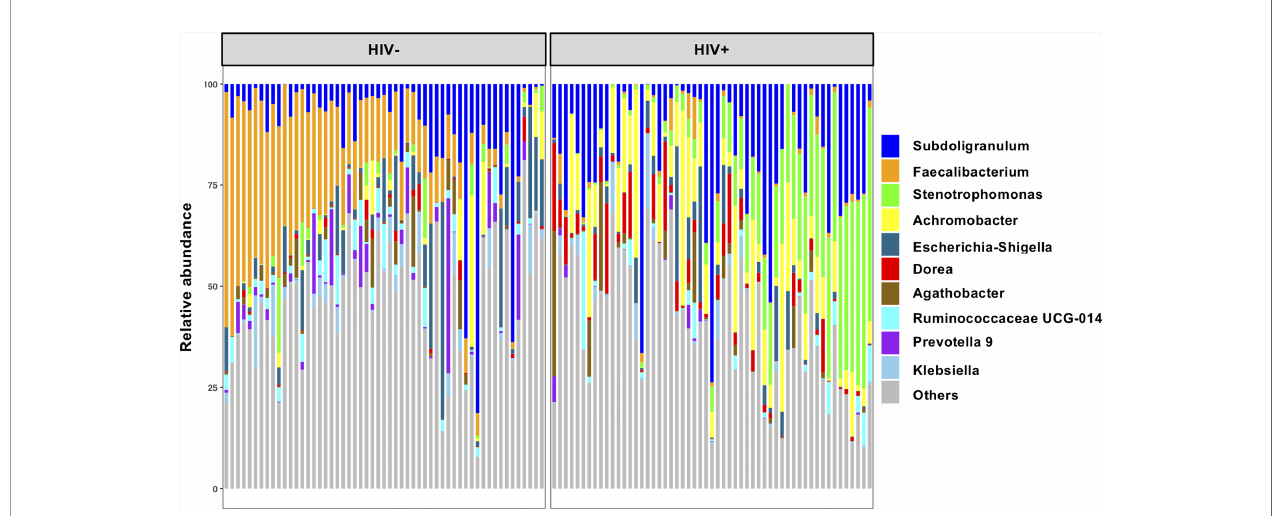
FIGURE 1 | Top 10 abundant genera in fecal microbiome in all participants in the present study. Taxa bar plots showing the top 10 abundant genera in all participants (n = 110) are shown. Each bar represents frequencies of the genera in fecal microbiome of an individual. HIV-, HIV-1 uninfected individuals (n = 55); HIV+, HIV-1 infected individuals (n =